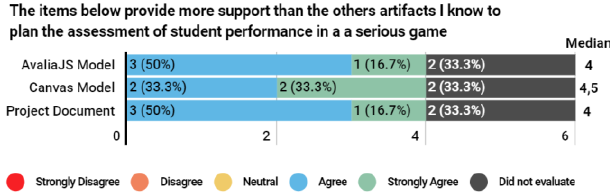
Figure 9. Experts’ answers regarding the support (item 7) of the AvaliaJS model.